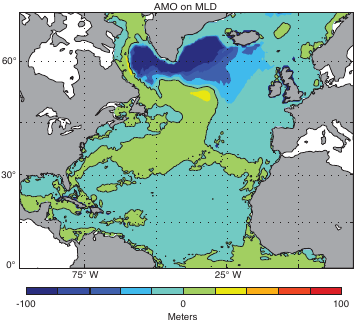
Figure 6. Regression of AMO on mixed-layer depth (MLD). Neg- ative values denote a shoaling of MLD.